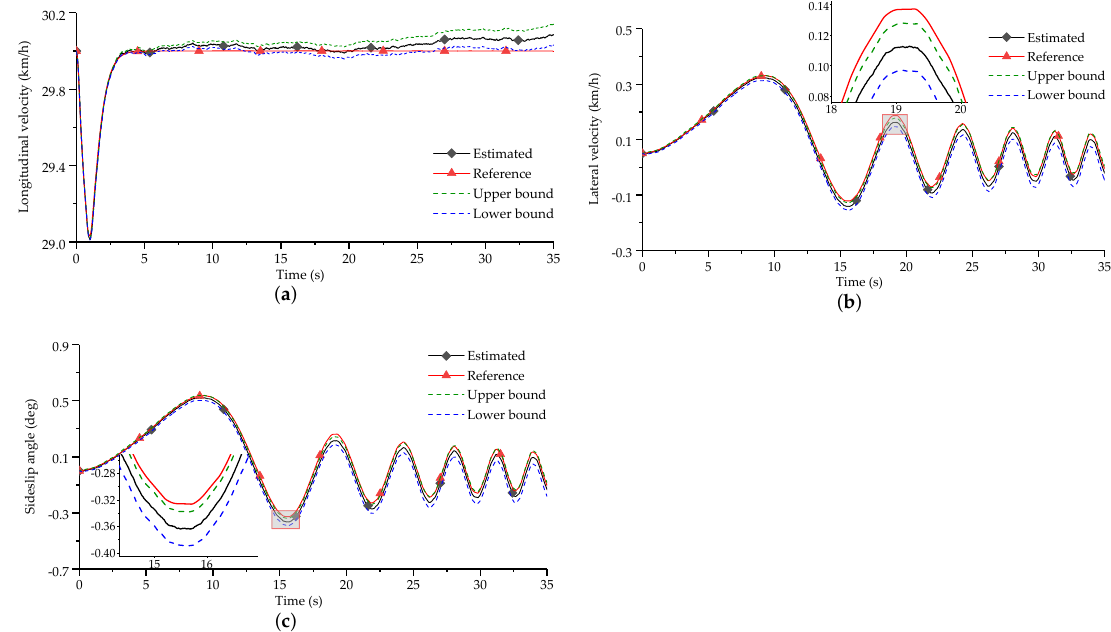
Figure 12. Results of the UKF-based strategy under the slalom maneuver. ( a ) Longitudinal velocity; ( b ) Lateral velocity; ( c ) Vehicle sideslip angle.